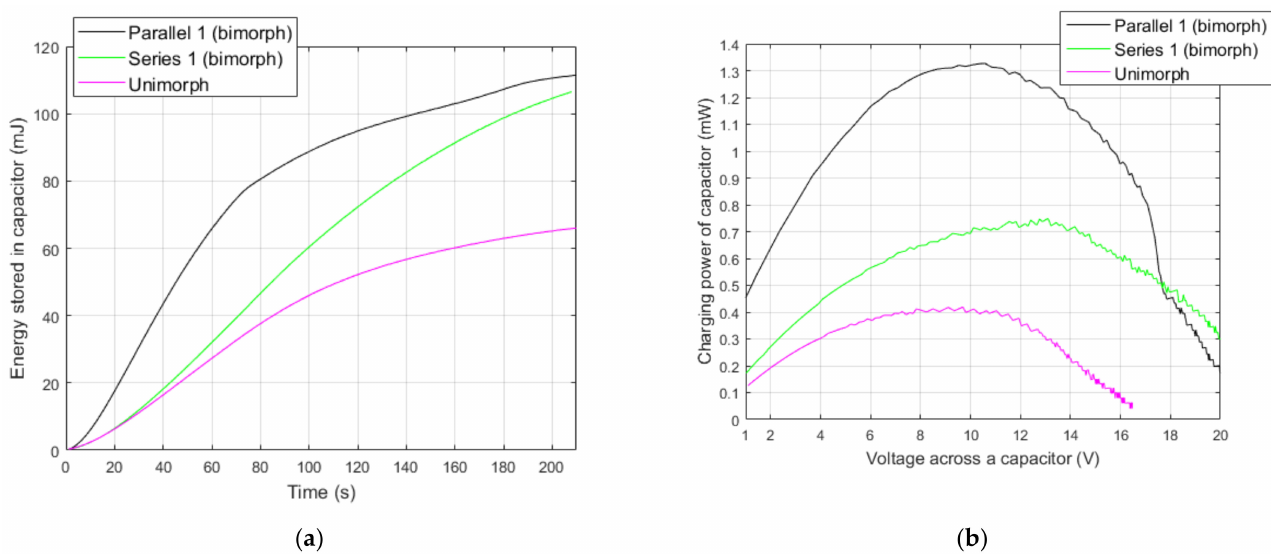
Figure 11. Characteristics of capacitor charging process: ( a ) energy stored in capacitor; ( b ) charging power of